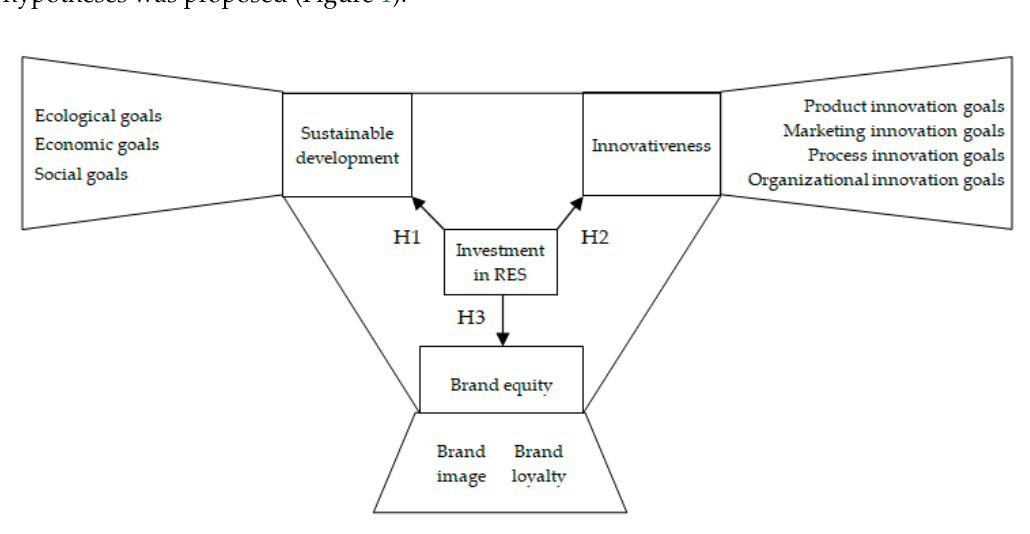
Figure 1. Model of renewable energy sources (RES) investment resonance in the areas of sustainable development, innovativeness, and brand equity.